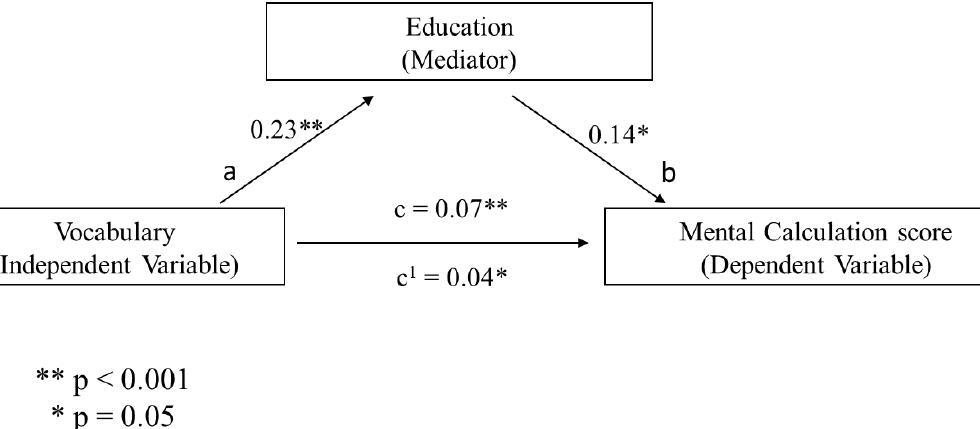
Figure 2. The predicted mediational pattern for Mental Calculation using CPM as the independent variable and vocabulary knowledge as mediator.